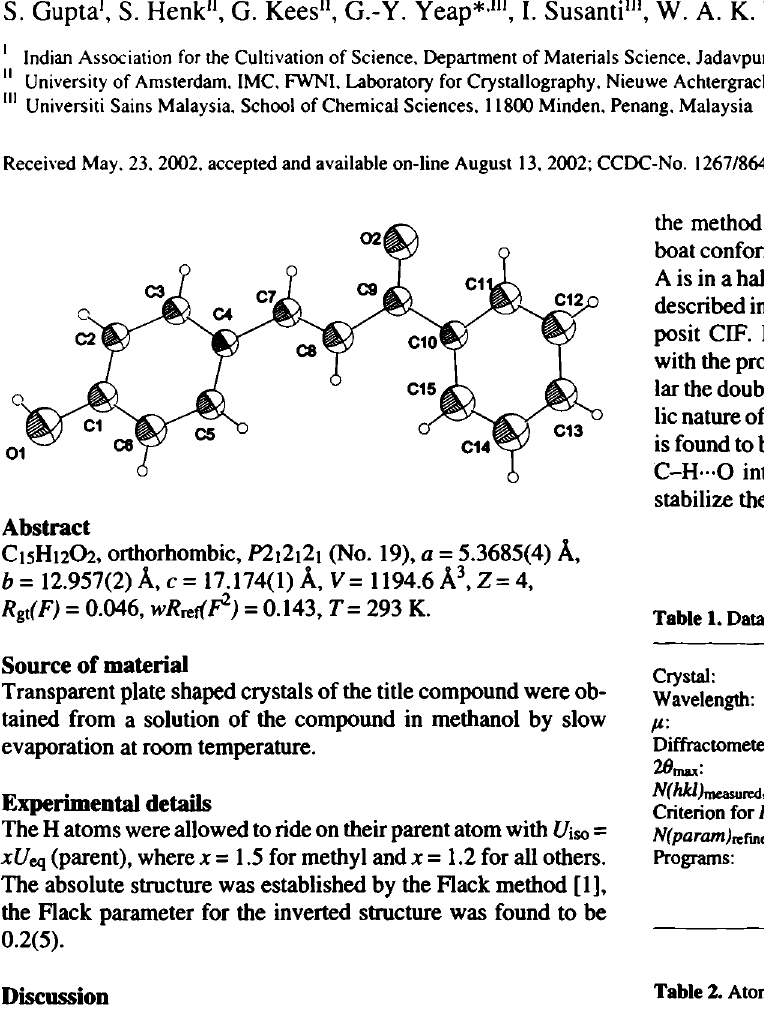
Table 2. Atomic coordinates and displacement parameters (in Â 2